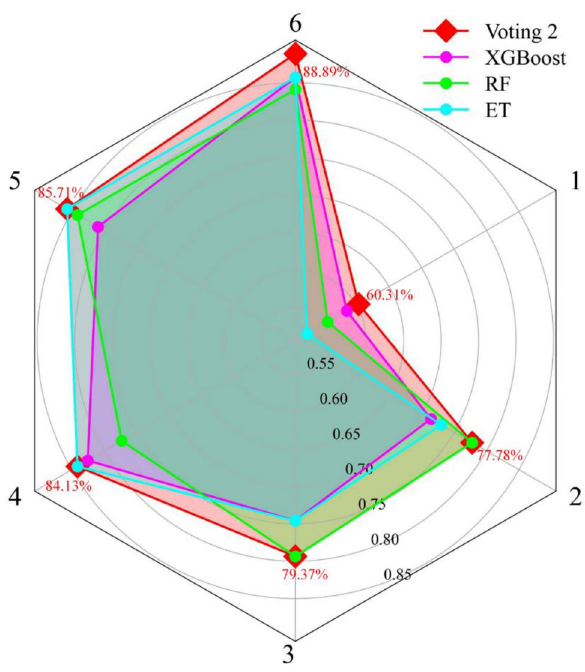
Figure 18. The accuracy in the test set when adopting different input